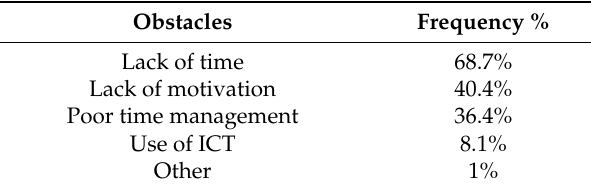
Table 3. Obstacles to a healthier lifestyle, multiple